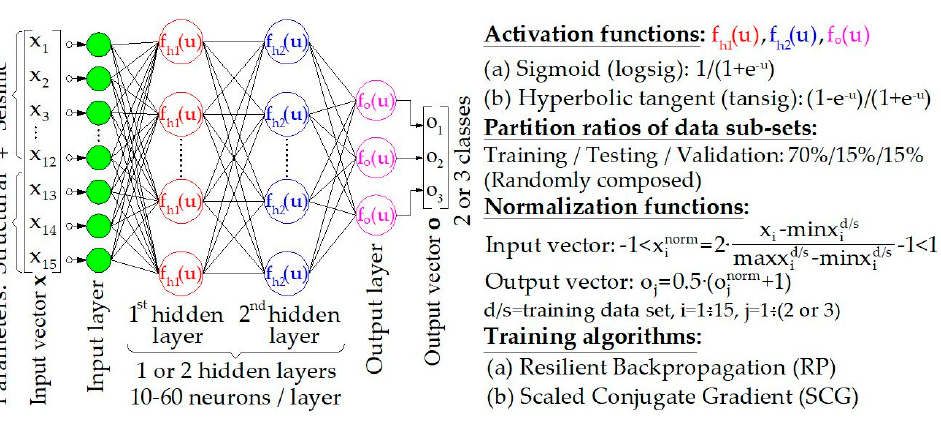
Figure 6. The general form of the used networks and the investigated configuration parameters.